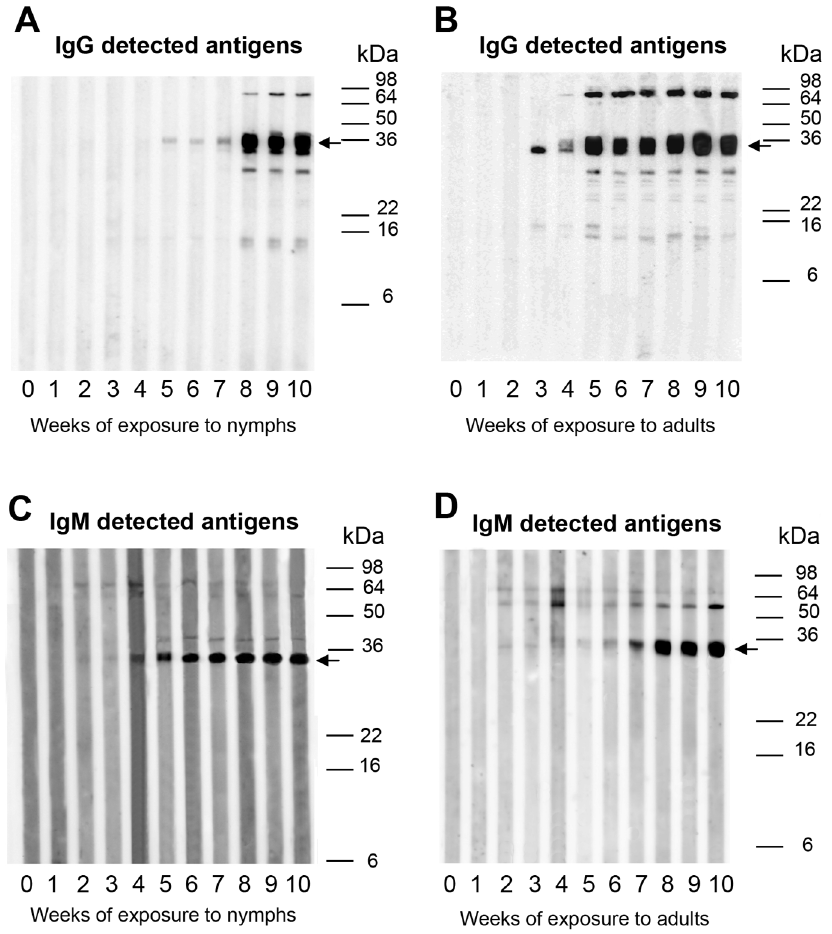
Figure 5. Immunogenic salivary antigens of T.infestans . Sera of guinea pigs that were weekly exposed to nymphal (A, C) or adult T. infestans (B, D) of the Bolivian strain over a period of 10 weeks (1–10) were used in Western blot experiments to detect IgG (A, B) and IgM (C, D) reacting antigens. A serum from a guinea pig prior to the exposure to bug bites was used as a negative control (0) in the Western blot experiments to demonstrate the specificity of the IgG and IgM anti-saliva T. infestans responses. Arrows mark the 35 kDa salivary protein that was detected in all Western blots by IgG and IgM antibodies.